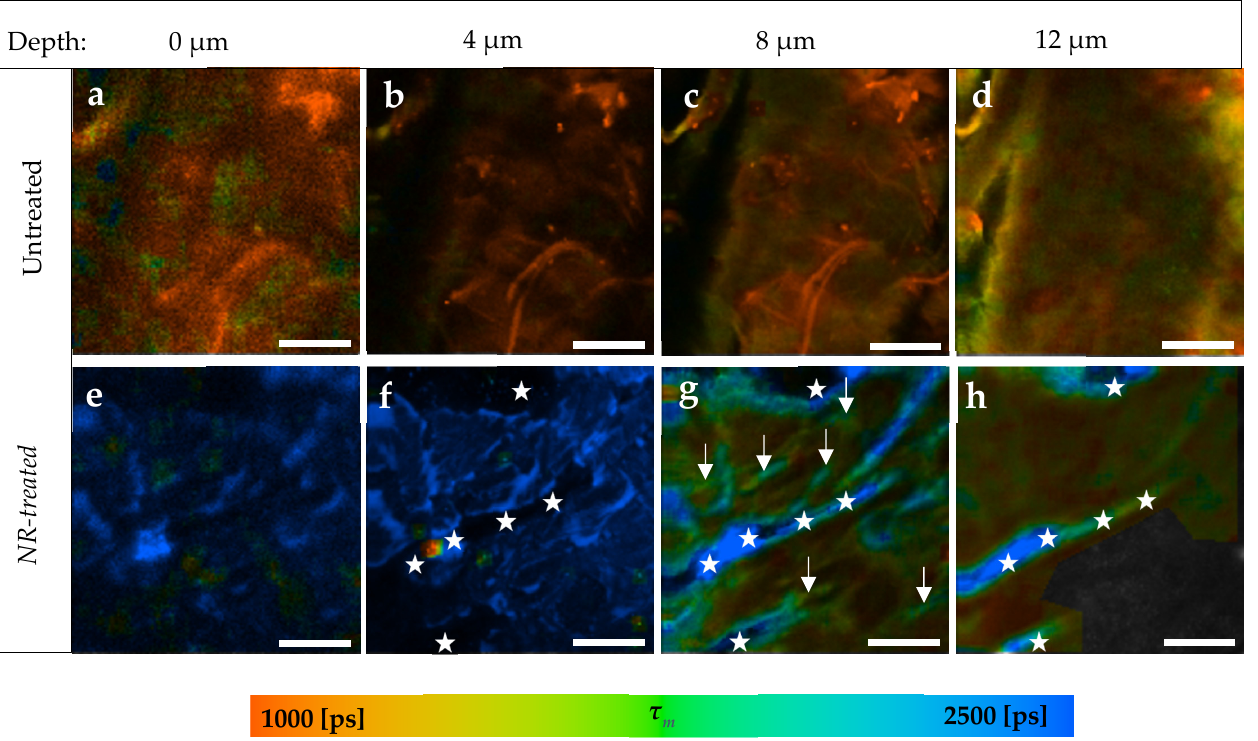
Figure 7. TPE-FLIM images of NR -treated compared to untreated skin depending on skin depth. ( a – d ) SC of untreated skin sample; ( e – h ) SC of NR -treated skin; ( g ) Arrows refer to areas with a longer τ m than the rest of the image indicating the presence of NR ; ( f ) The stars refer to the background and stars in ( g , h ) refer to the skin surface because of skin furrow. T m was measured after an excitation with 760 nm using a TPT and is shown by a pseudocolor scale of 1000–2500 ps. Scale bar: 20 µ m. Acquisition time: 6.8 s. Excitation power is depth-dependent and shown in Table 1.